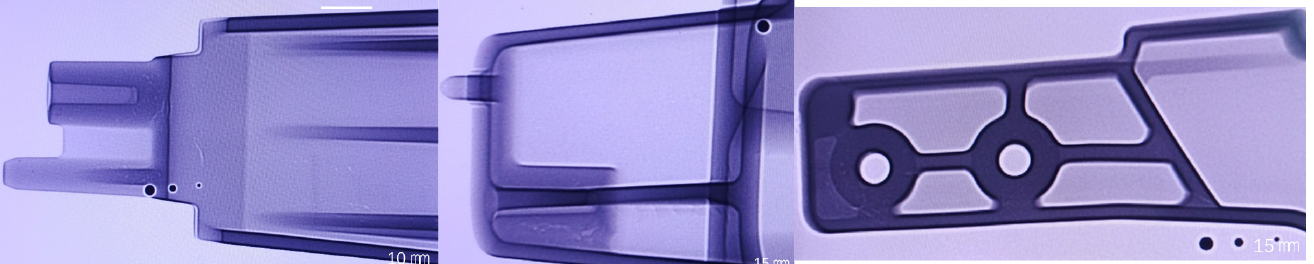
Figure 12. X-ray test after optimization.